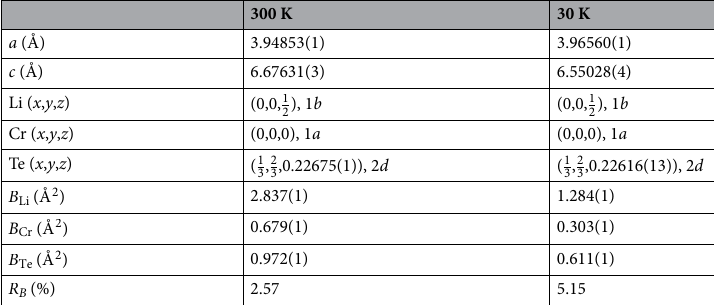
Table 1. Summary of the structural parameters for polycrystal LiCrTe 2 refined from synchrotron XRD measurements. A trigonal spacegroup P 3 m 1 (#164) was used for the entire temperature range with 90 120 α β ◦ and γ = ◦ . Also note that refinement of fractional occupancies using both XRD and NPD = = data resulted in virtually stoichiometric composition (i.e. full occupancies for all